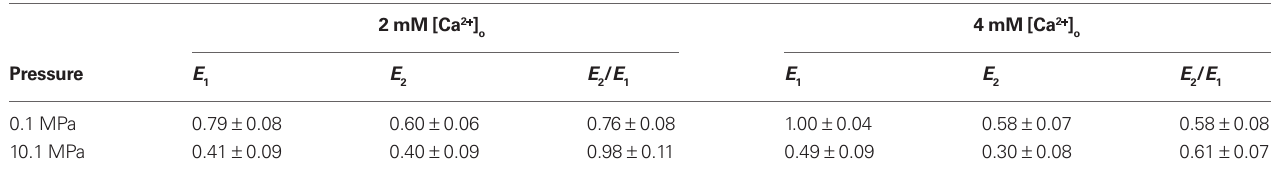
Table 2 | effects of pressure and [Ca 2 + ]